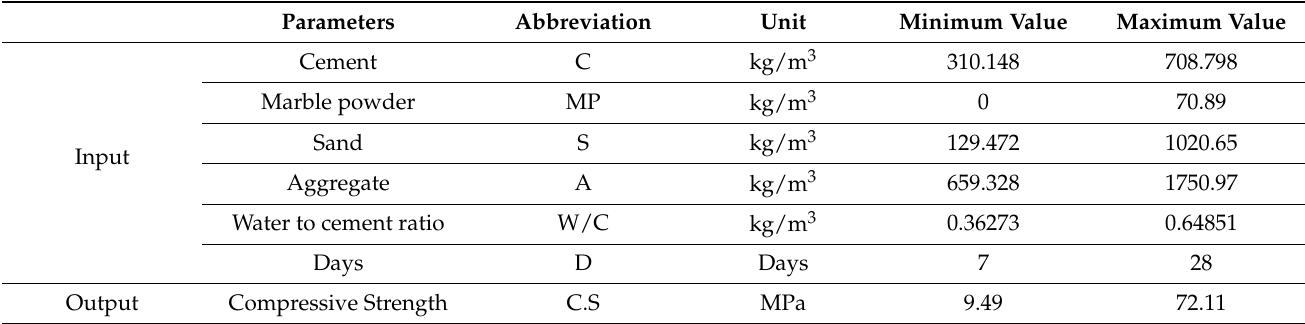
Table 5. Input and output variables